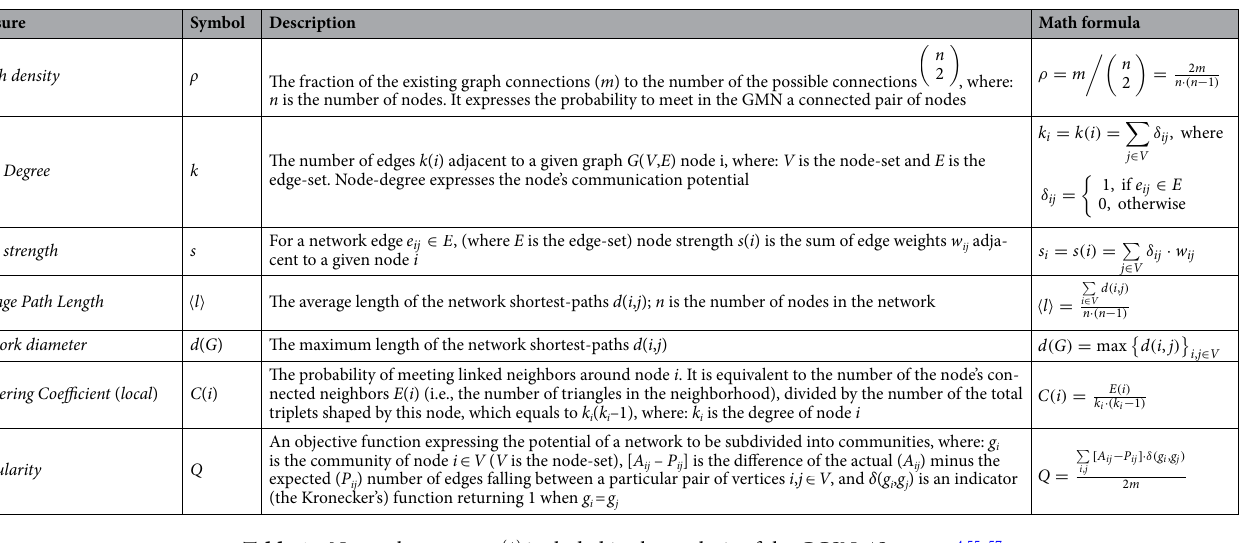
Table 1. Network measures ( * ) included in the analysis of the GCSN. *Sources: 4,55–57